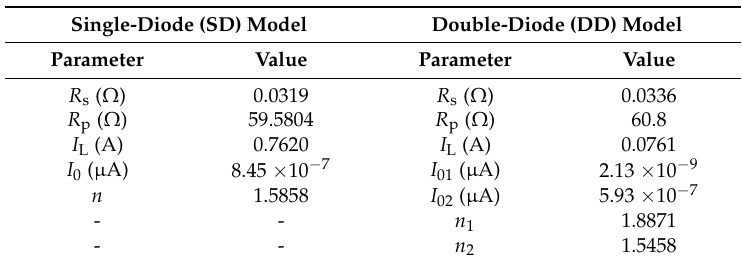
Table 3. PV cell parameters for the SD and DD models, extracted by applying the proposed CGSA-6 approach.